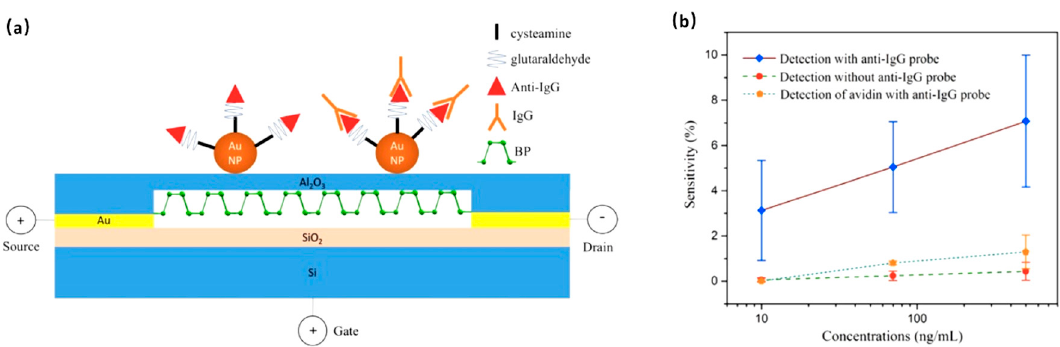
Figure 6. ( a ) Schematic of black phosphorus biosensor for HIgG, and ( b ) plot of sensitivity as a function of target and non-target antigen concentration [42]. Reprinted with permission from ref [42]. Copyright 2016, Elsevier B.V.